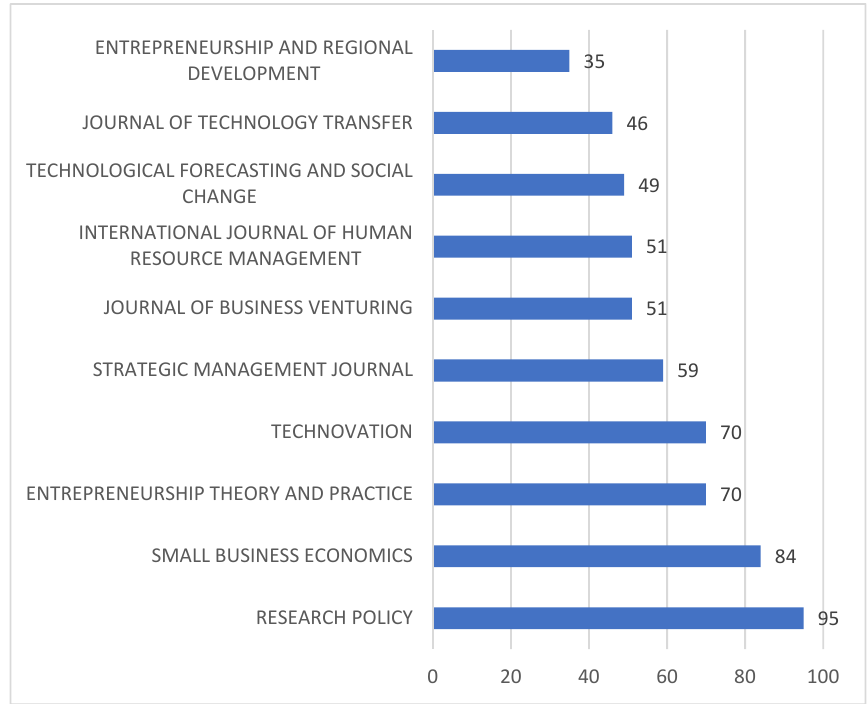
which 1000 were gathered in the final sample. In Figure 4, the cited documents can be visualized. The larger nodes represent the most cited articles, as the larger the node, the more citations that specific document has. Also, the relatedness of the publications can be visualized, as the closer two nodes are, the greater the number of times those publications cite each other. The article with the higher number of citations (2379), was published in the Strategic Management Journal in 2006, by Laursen and Salter [56]. To better identify the most cited documents, the top 10 most cited publications are presented in Table 2. This way, the most prominent publications can be identified [57], as well as the main nodes and relative importance of the highly cited works (see Figure 4).